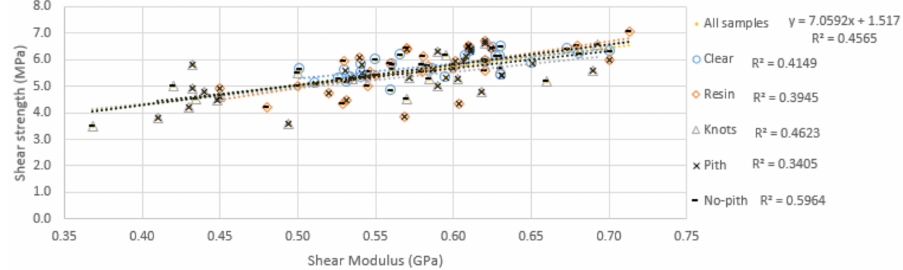
Figure 27. Relationship of shear modulus and shear strength.